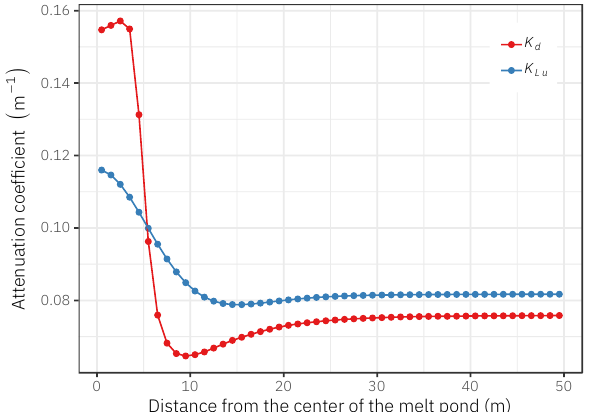
Figure 8. Simulated local downward irradiance and upward radiance profiles (expressed in relative units) at different horizontal distances from the centre of the melt pond (see Figure 1) used to compute K d and K Lu . These attenuation coefficients were used to propagate surface reference downward irradiance ( E d ( 0 − ) , the surface values of the lines in Figure 7) through the water column.